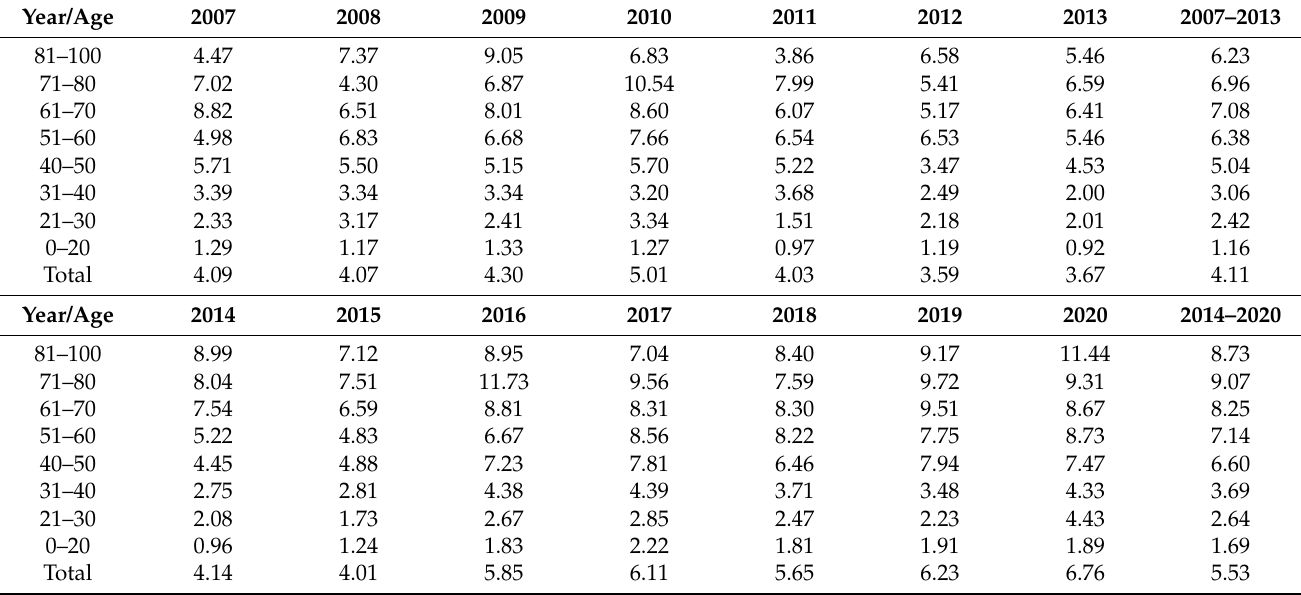
Table 1. Prevalence of PN per 1000 dermatology outpatient